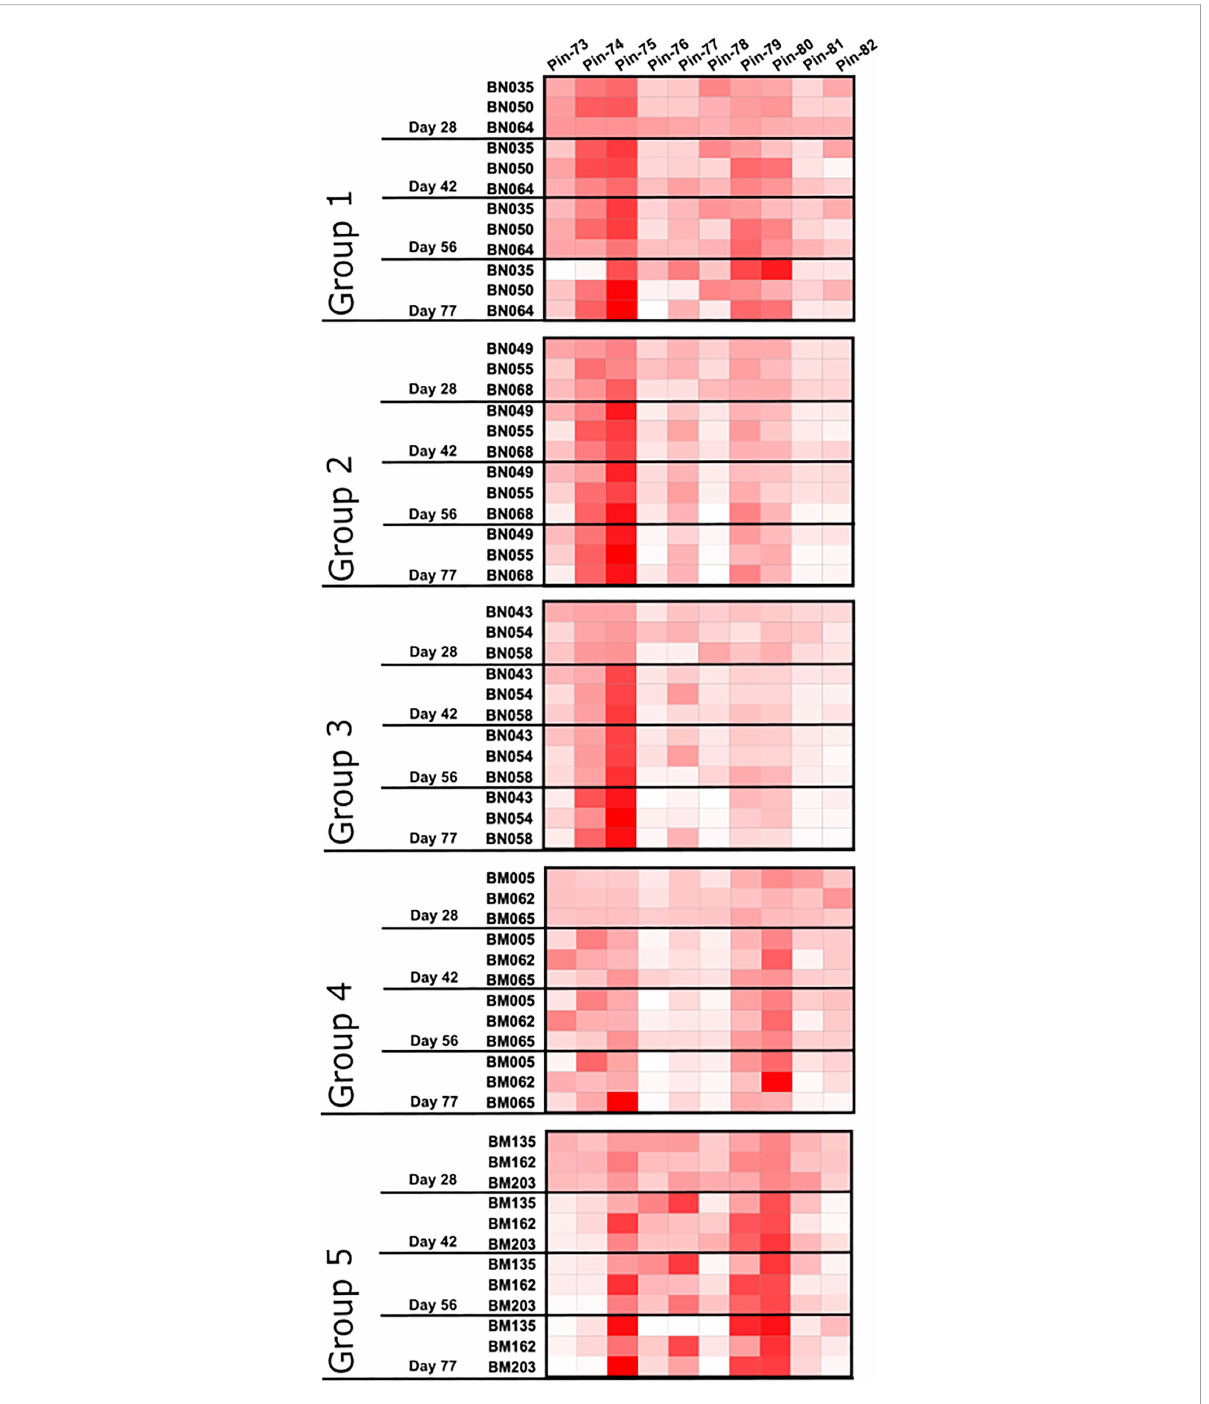
FIGURE 5 Pattern of antibody reactivity to p67C 15-mer overlapping peptides in animals subjected to immunogenicity studies. Pattern of IgG reactivity to overlapping 15-mer p67C peptides (named pins, as previously described in (40)), at day 28, 42, 56 and 77 after fi rst dose of